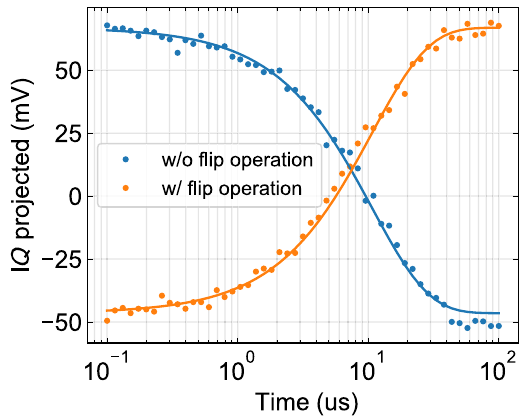
FIG. 9. T1 decay experiment. The horizontal axis represents the delay time, the vertical axis represents the projected value of the IQ readout signal. The blue and orange dots represents the experimental results of the T1 decay experiments with and without flip operation just before measurement, respectively. The lines are fitting curves.